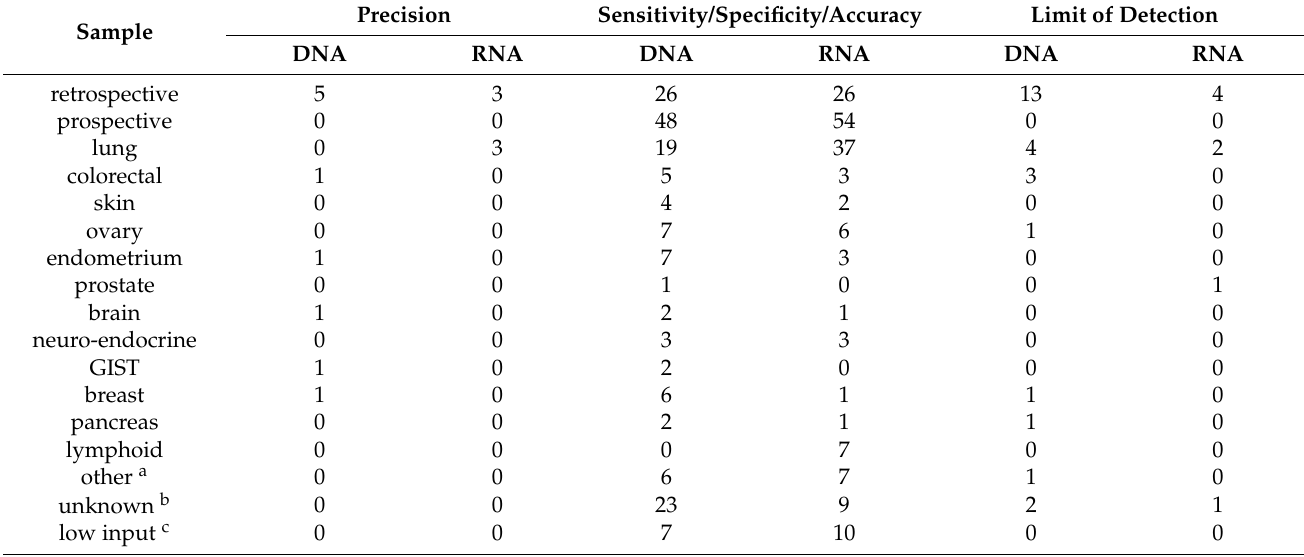
Table 2. Number of sample types used for the TSO500 validation